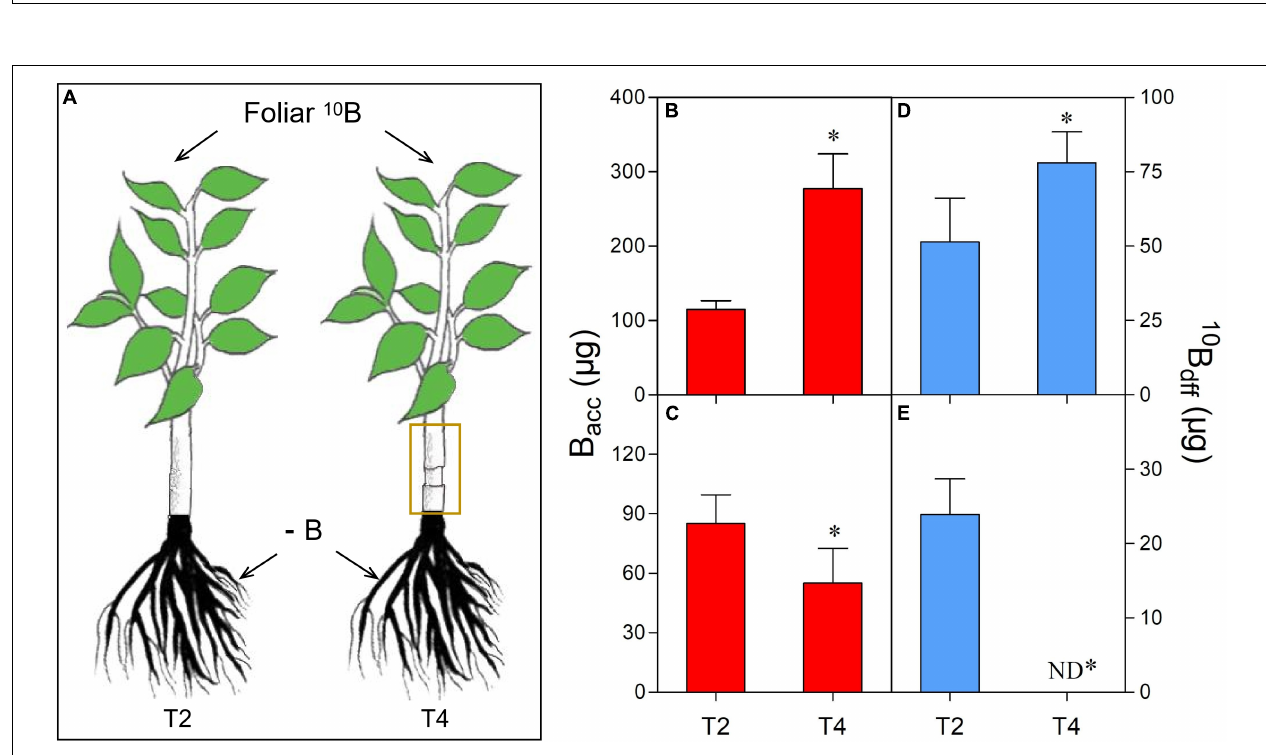
FIGURE 1 | Comparison of proportion of 10 B ( 10 B pro ) and 10 B concentration derived from the foliar 10 B ( 10 B dff ) in leaves (B,D) and roots (C,E) , and the ratio of root 10 B dff /leaf 10 B dff (RB dff /LB dff ), (F) of different treatments (A) . Figure (A) shows three treatments: gray boxes refer to foliar application of ultra-pure water to B deficient seedlings as treatment 1 (T1); yellow boxes refer to foliar 10 B application to B deficient seedlings as treatment 2 (T2); green boxes refer to foliar 10 B application to B sufficient seedlings as treatment 3 (T3). Different lower-case letters indicate the significant difference between treatments at P < 0.05 as determined by the Duncan’s multiple range test.